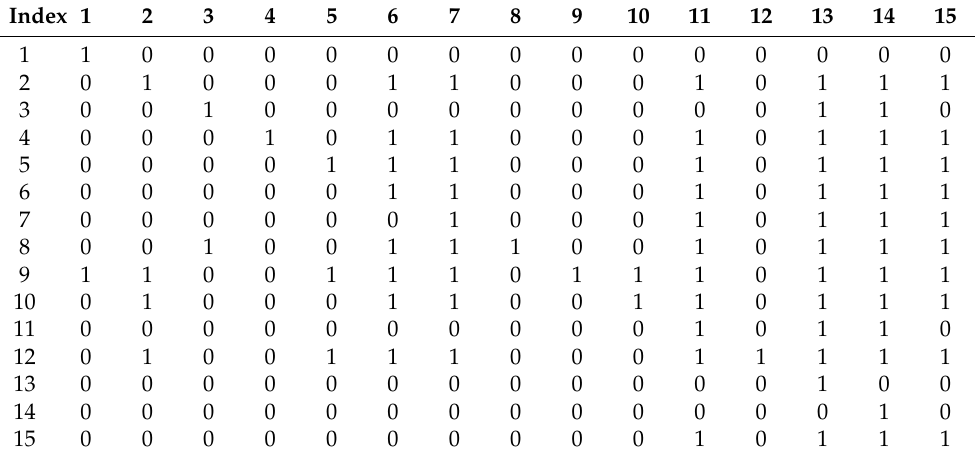
Table 5. The reachable